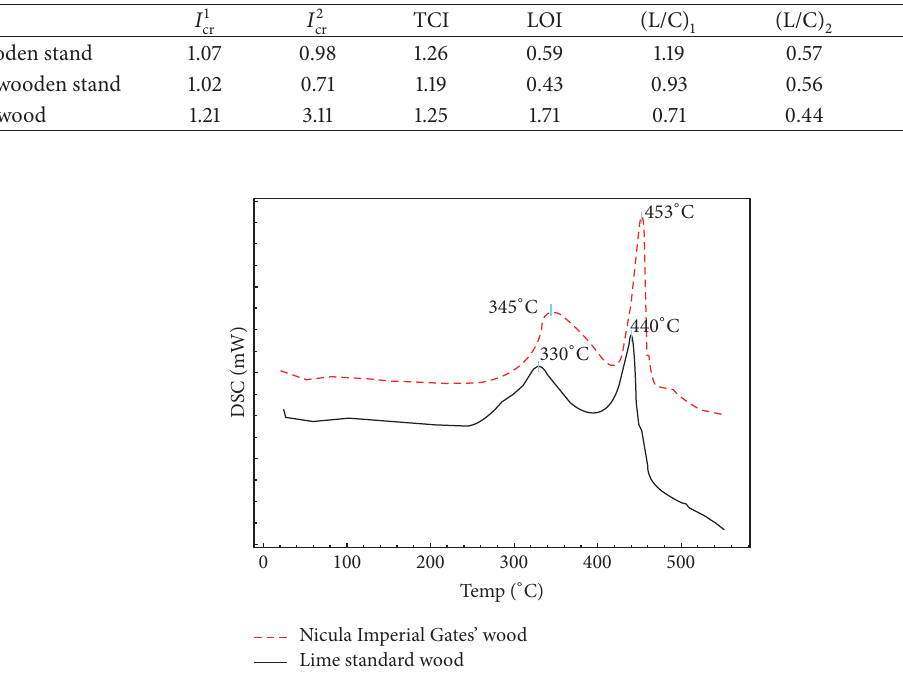
Figure 7: DSC curves of Nicula Imperial Gates and of lime species standard wood.